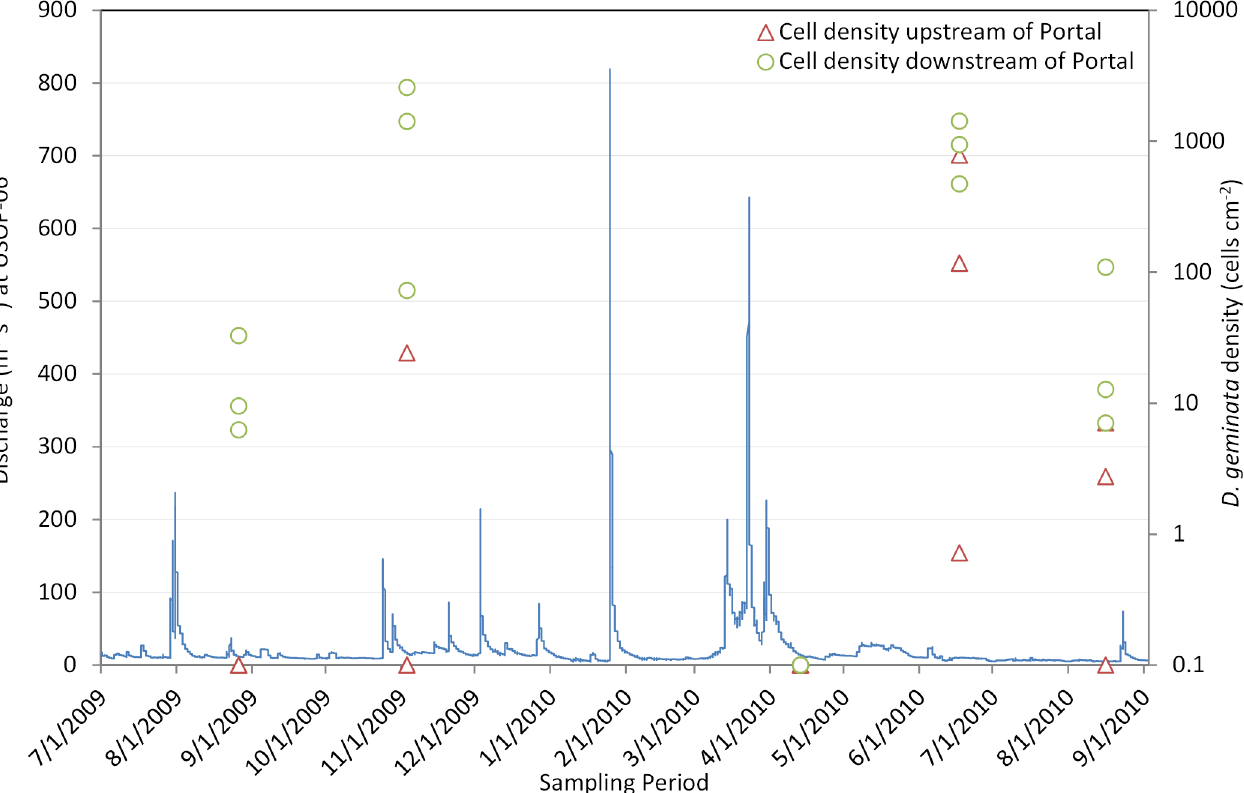
Fig 2. Continuous (15-minute) discharge at USOP-06 and cell density of D . geminata from seasonal sites upstream of the Shandaken Portal (red triangles) and downstream of the Shandaken Portal (green circles) during the five surveys conducted between 8/1/2009 and 9/1/2010 [all zero values (no detection) were replaced with 0.1 to facilitate plotting in log